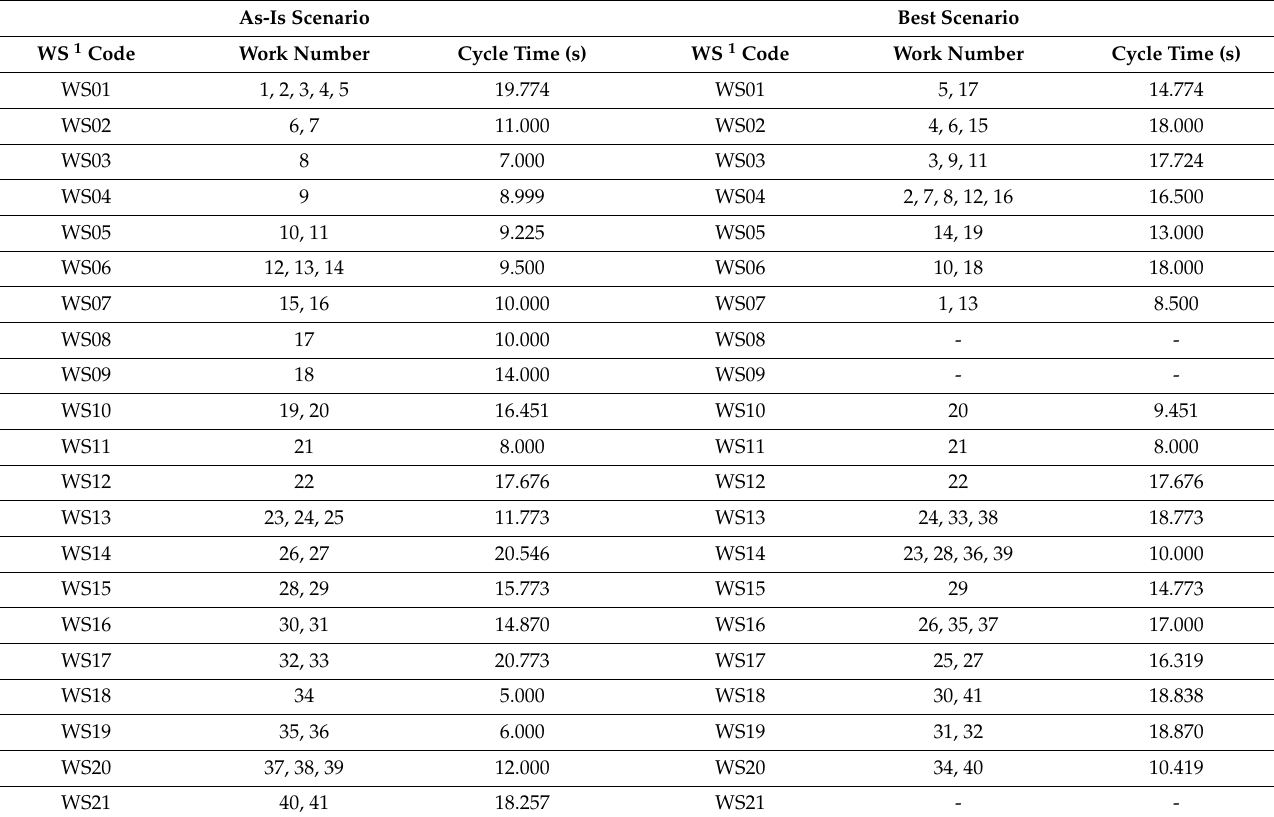
Table 5. Comparison of the as-is scenario and best scenario.